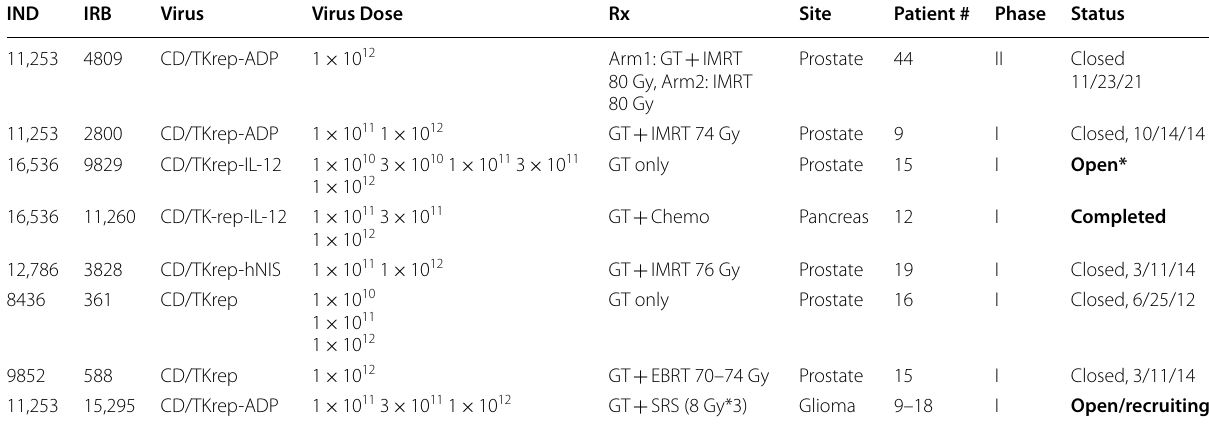
Open*: Not recruiting new patients, long term follow-up only. IRB not yet officially